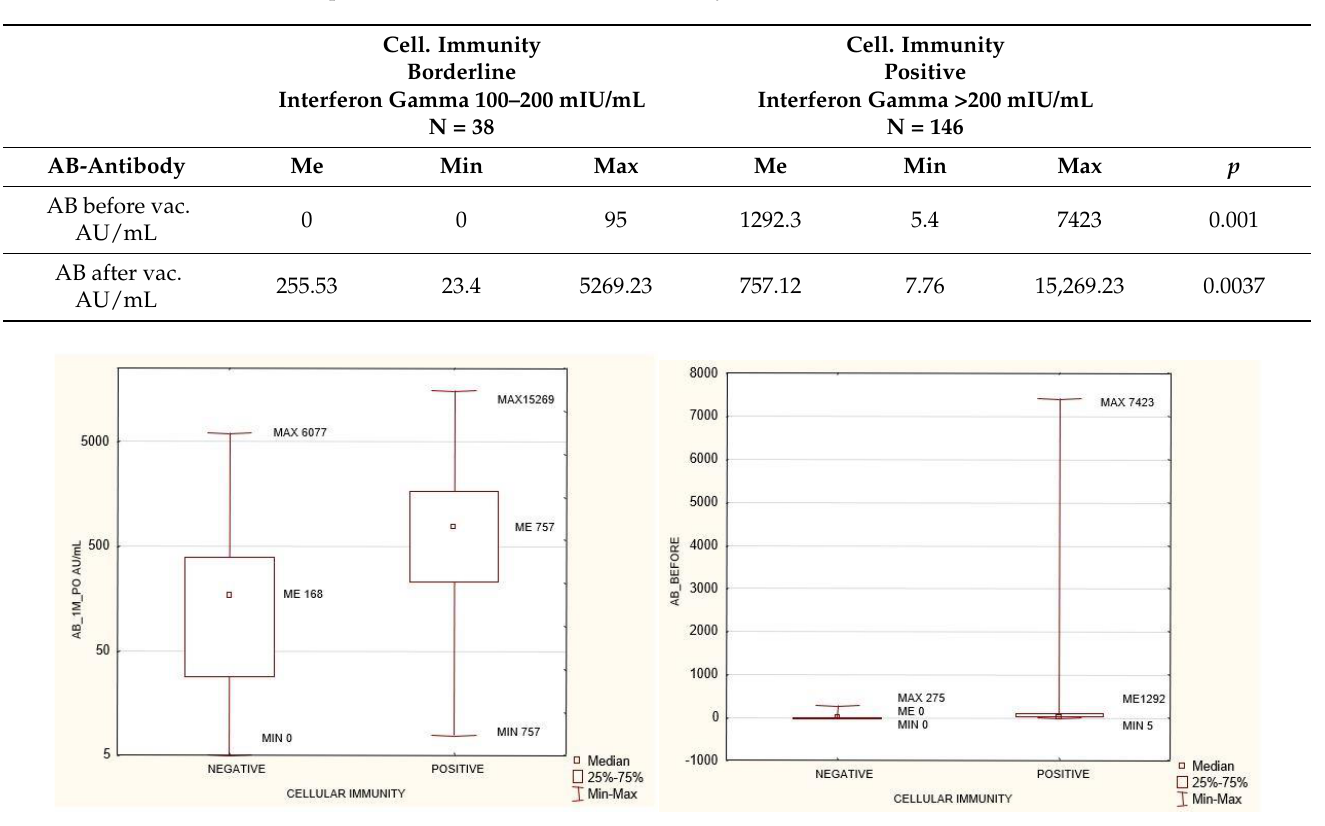
Table 2. Anti-SARS-CoV-2 antibody levels prior to and after vaccination in groups that developed positive or borderline cellular immunity.